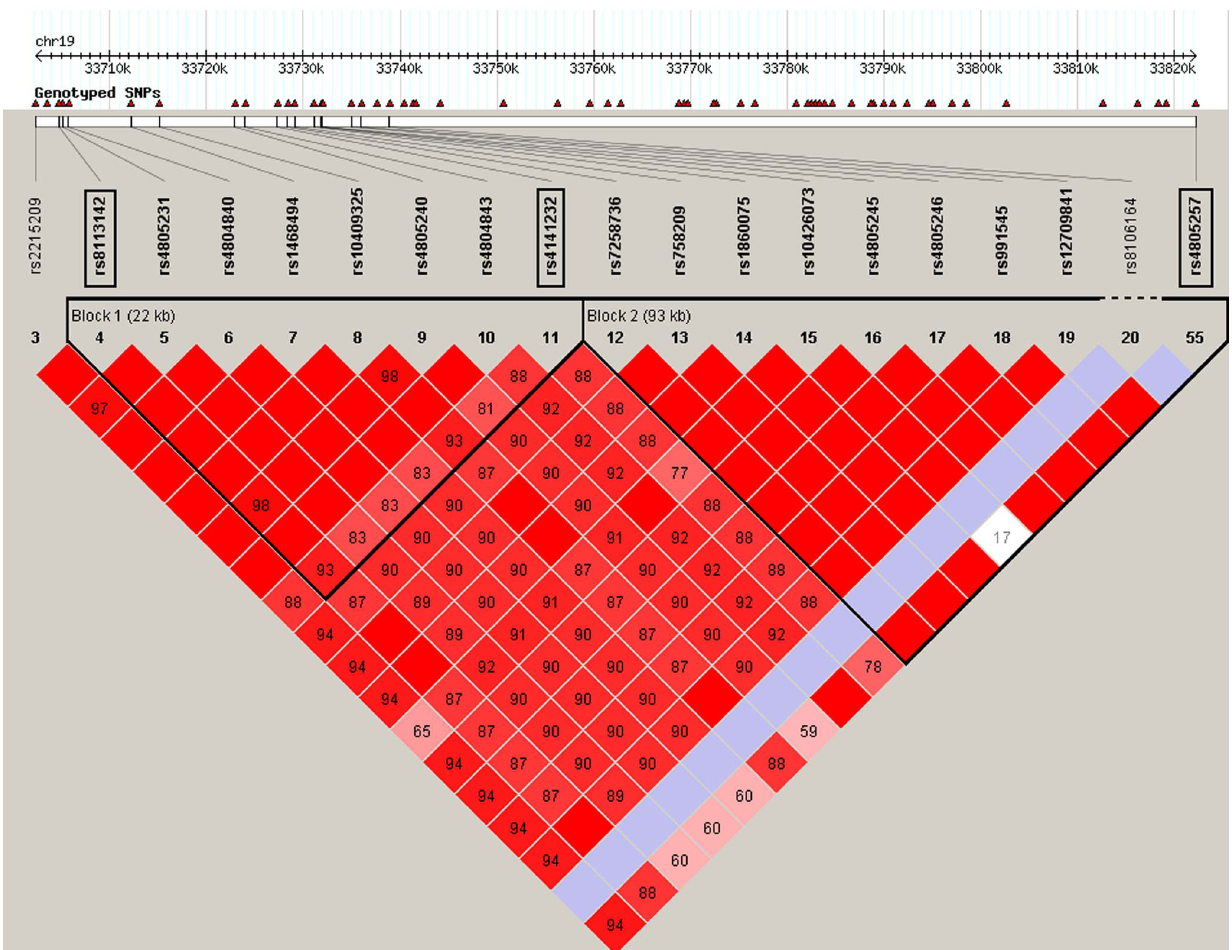
Figure 3. LD structure of the upstream of LOC148145 gene in the discovery Caucasian sample. The region demarcated in red indicates that r 2 . 0.9. The region includes two LD blocks (Block1 and Block2) marked by triangles with black lines. SNPs rs8113142 and rs4141232 are located in Block1, and the SNP rs4805257 is located in Block 2.